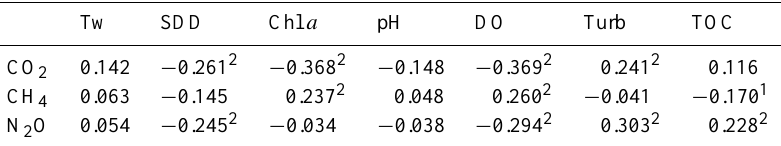
Table 1. Correlation between GHG fluxes and water environment variables at 0.5-m depth of the TGR. The variables including surface water temperature (Tw), Sesschi disk depth (SDD), chlorophyll a (Chl a ), pH, dissolved oxygen (DO), turbidity (Turb) and total organic carbon (TOC).